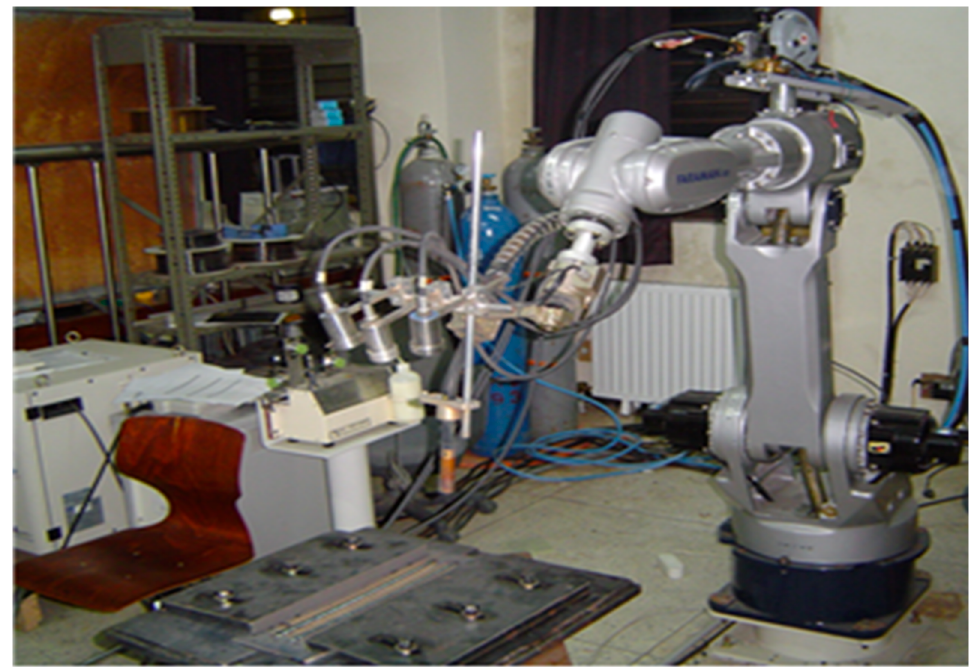
Figure 5. Welding system for the experiment.